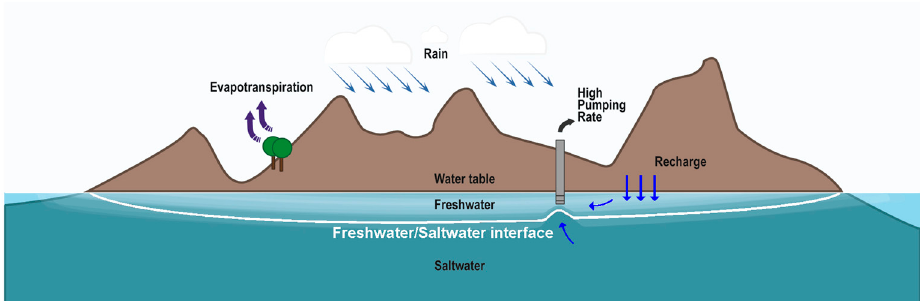
Figure 1. Small islands’ typical freshwater lens-shape over the brackish/salt water. The effect of a pumping well (upconing) is indicated.